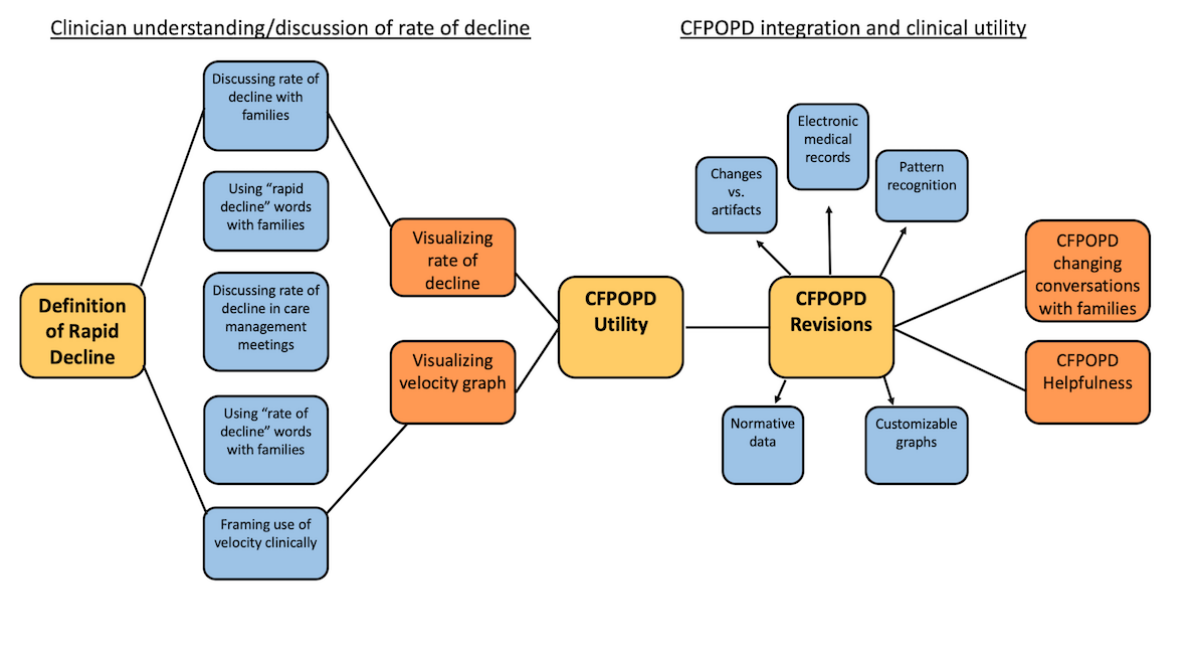
Figure 5. Conceptual clinical model of rapid decline. Larger yellow-shaded boxes with bold text represent key discussion points during focus group sessions. The first half of the diagram summarizes clinician understanding and discussion with other care team members and patients/families. Clinicians translated concepts of rapid decline into optimizing Cystic Fibrosis Point of Personalized Detection (CFPOPD) data visualization/monitoring capabilities. The second half represents CFPOPD integration and clinical utility. Clinicians identified challenges to the user interface and suggested revisions. The rightmost boxes represent clinician feedback on how the use of CFPOPD would change the conversations with families or otherwise be